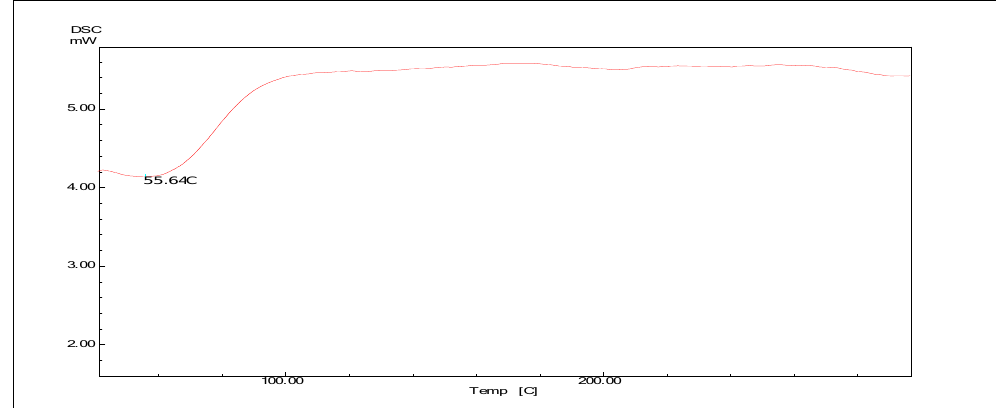
Figure (13) DSC thermogram of HPMC